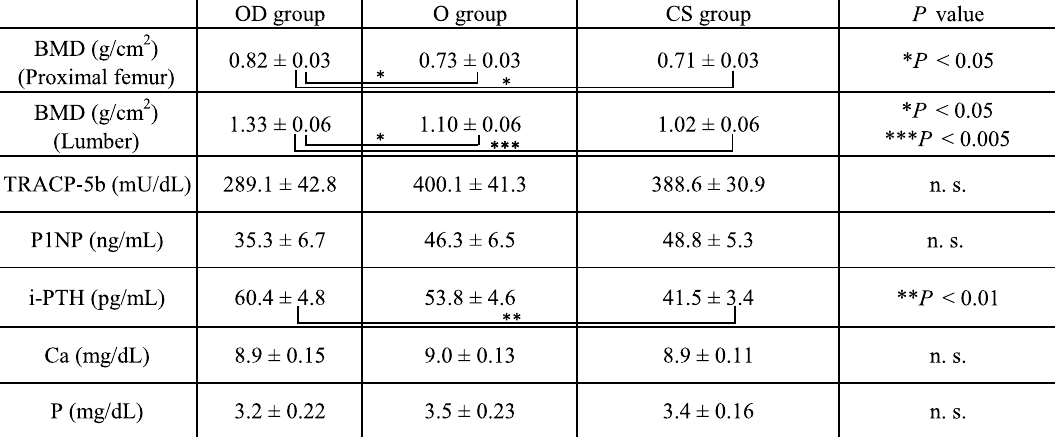
Table 2. Bone mineral density and factors associated with bone turnover (mean ± standard deviation) for